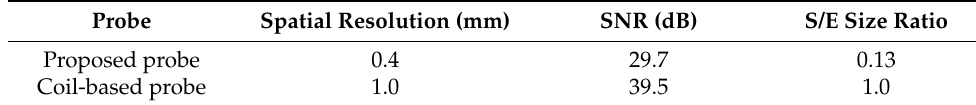
Table 5. The comparison between the proposed probe and the coil-based probe.